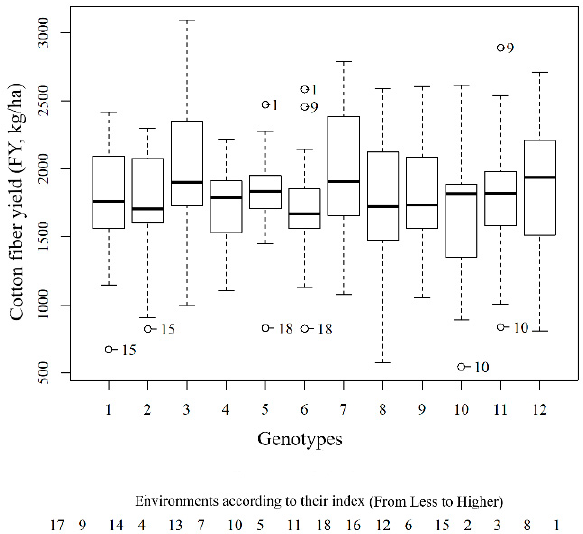
Figure 1. Boxplot of yield of 12 early cotton genotypes evaluated in each one of 18 Brazilian Cerrado